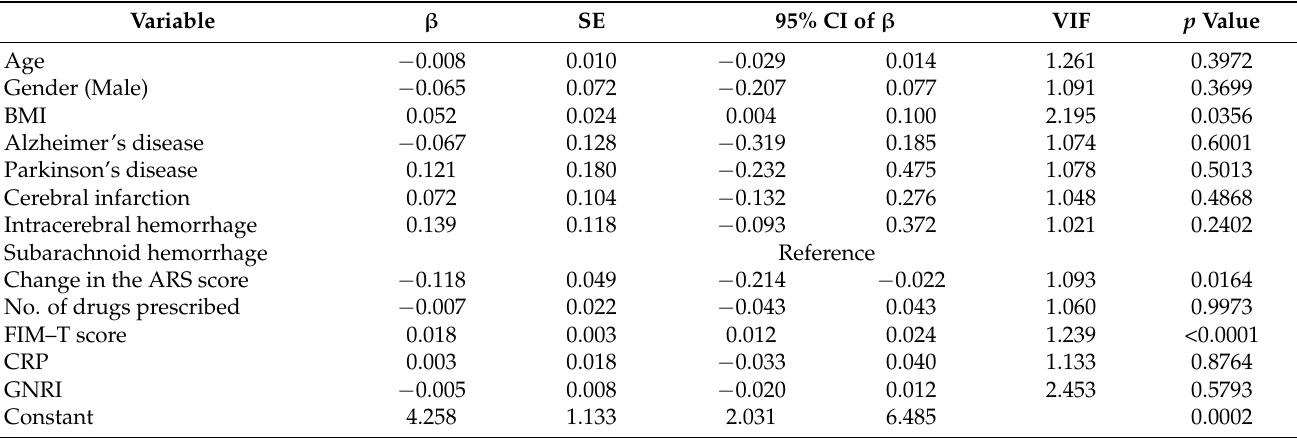
Table 3. Multiple linear regression analysis for FOIS score at